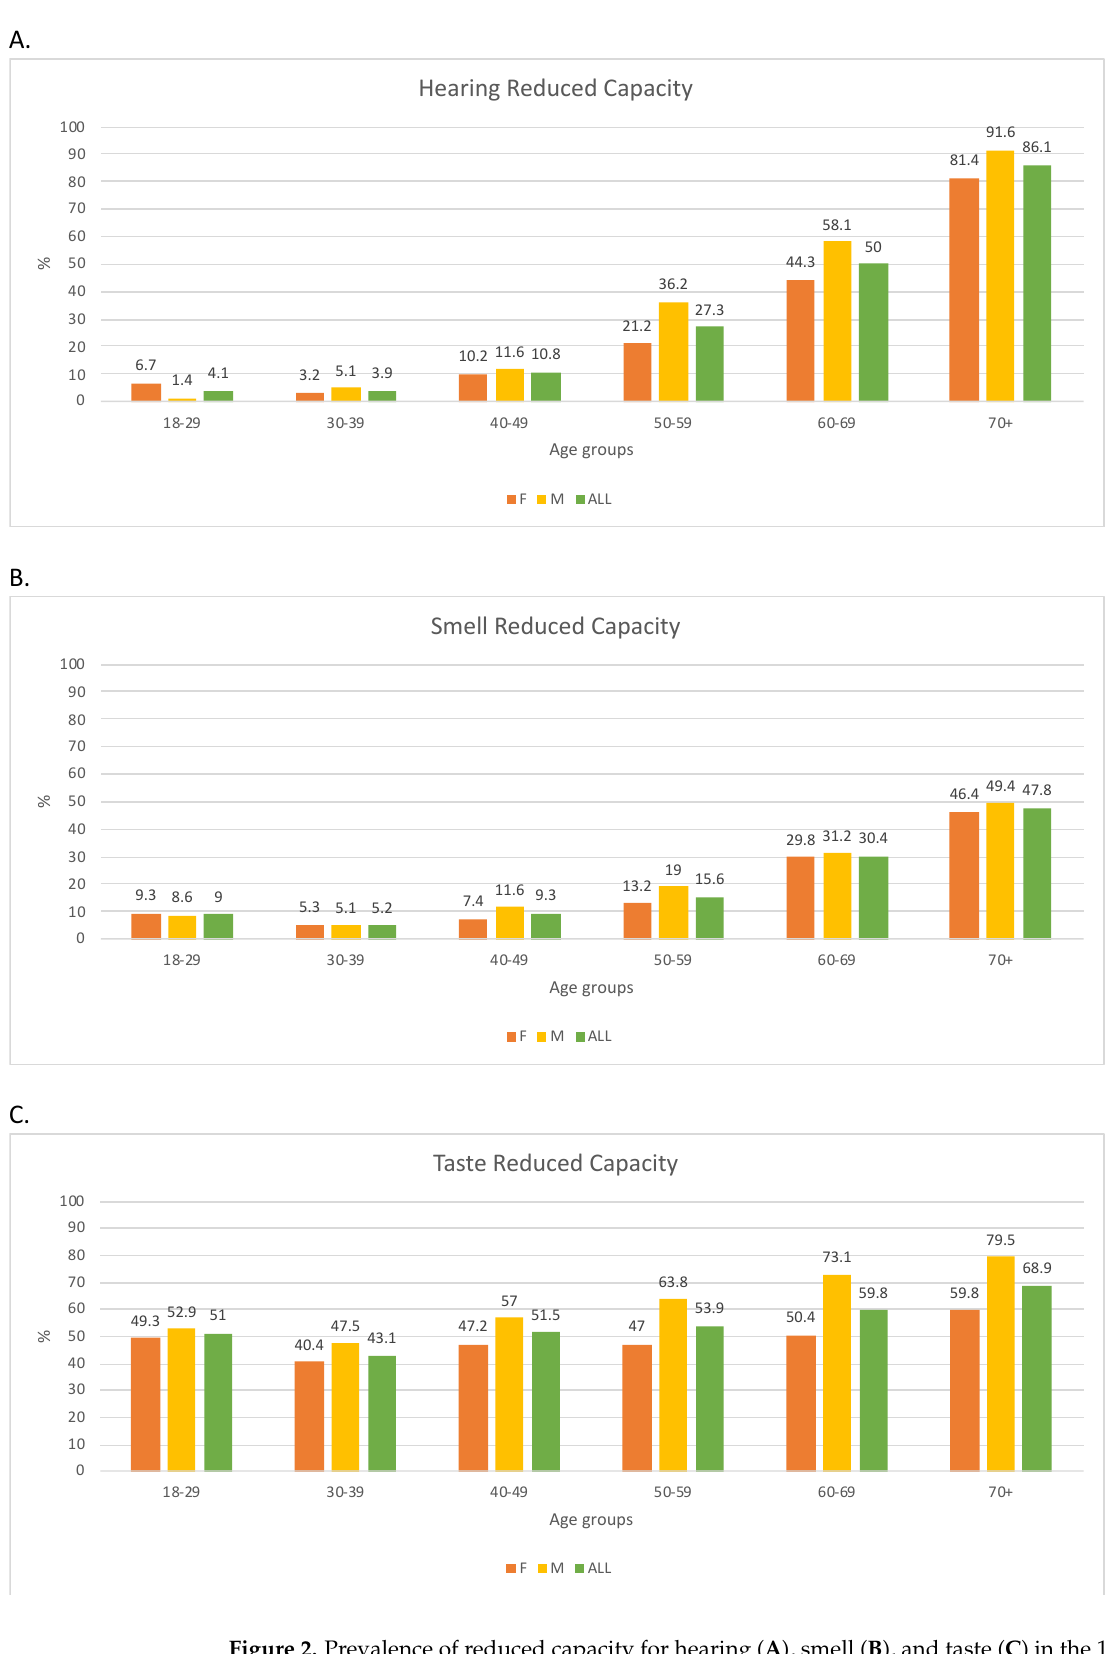
Figure 2. Prevalence of reduced capacity for hearing ( A ), smell ( B ), and taste ( C ) in the 10-year age groups for females (orange bars), males (yellow bars), and overall (green bars). The y -axis indicates the age groups, and the x -axis presents the prevalence as a percentage. The numbers above the bars are the